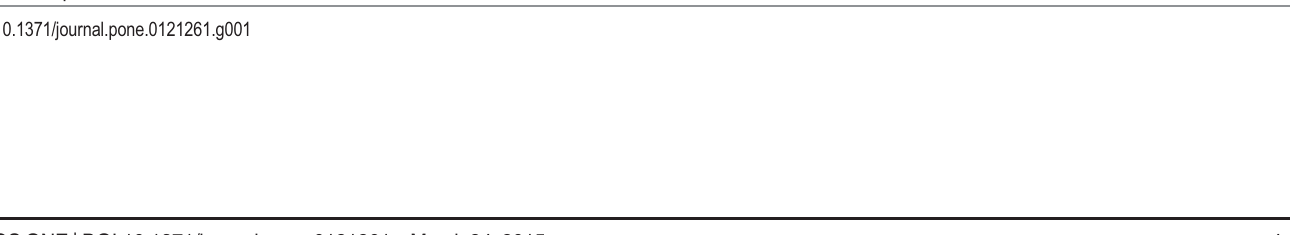
PLOS ONE | DOI:10.1371/journal.pone.0121261 March 24,